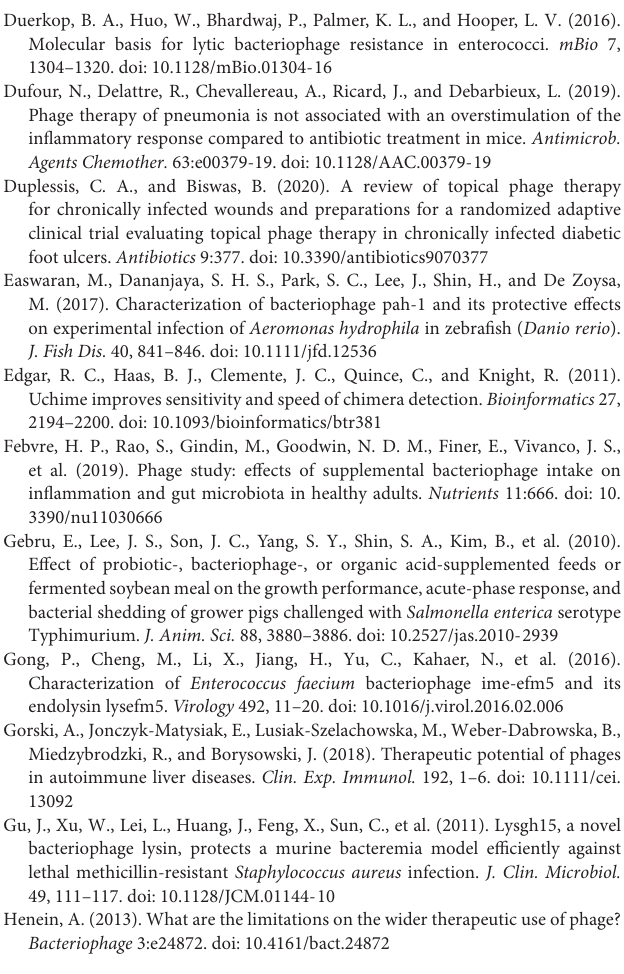
Supplementary Figure 1 | The effects of A. hydrophila challenge and phage therapy on the composition of the gut microbiota. (A) Redundancy analysis (RDA) revealed the relationship between inflammatory factors and Intestinal flora in different groups. (B) Heatmapping shows that the abundance of intestinal bacteria at the genus level was significantly altered by treatment with phage PZL-Ah152 in challenged and normal